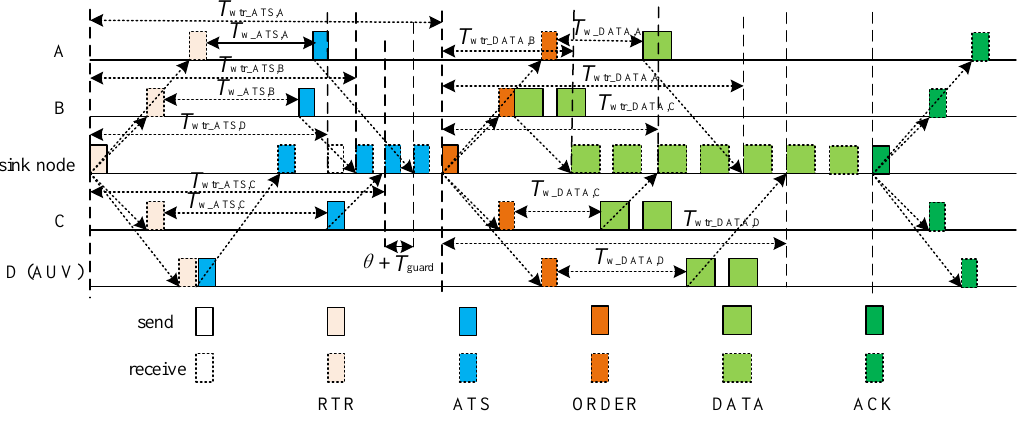
Figure 2. The process of data transmission in ReSerVation-based medium access control (RSV-MAC) protocol.